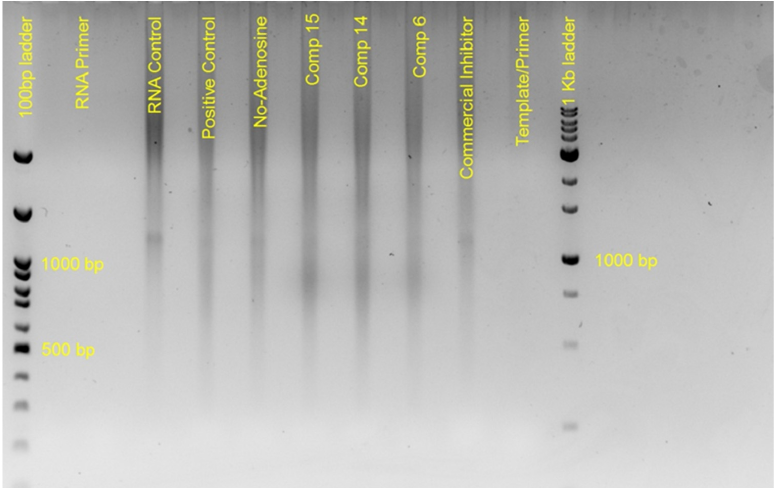
Figure 8. In-vitro assay using NSP12 polymerase and different adenine nucleoside inhibitors.